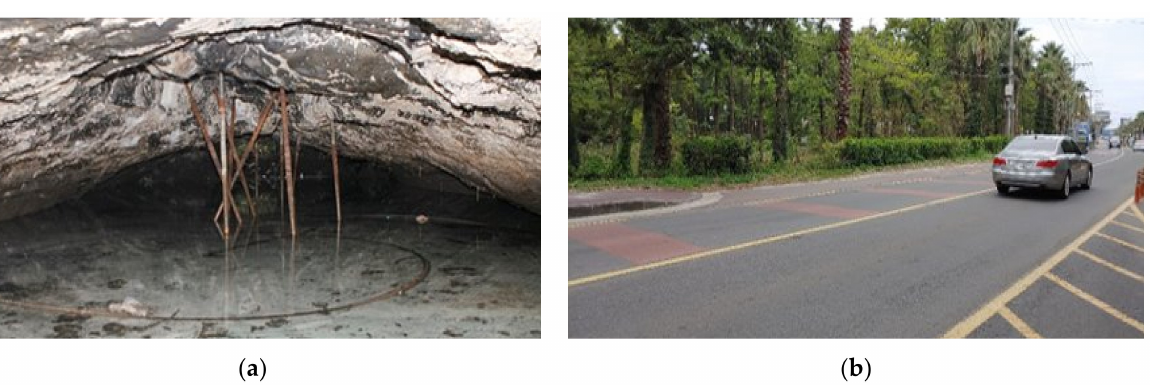
Figure 1. Jeamcheon lava tube on Jeju Island. ( a ) Inside of Jeamcheon lava tube; ( b ) upper road of Jeamcheon lava